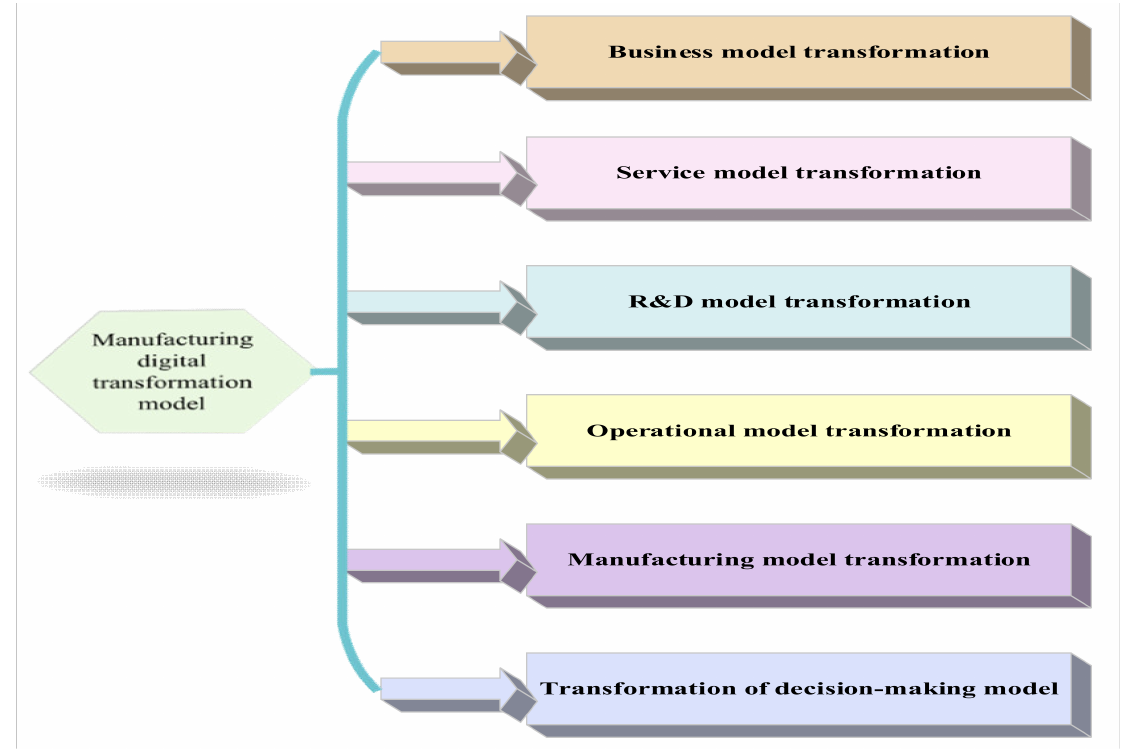
Figure 2. Common modes in EDT for manufacturing